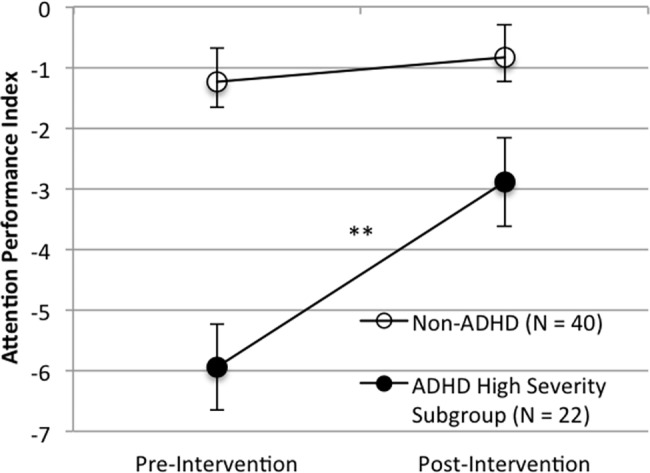
Performance on the TOVA API pre- and post-intervention for the ADHD High Severity subgroup and the non-ADHD group.Note: Error bars represent standard error of the mean (*p < 0.05; ** p < 0.005).